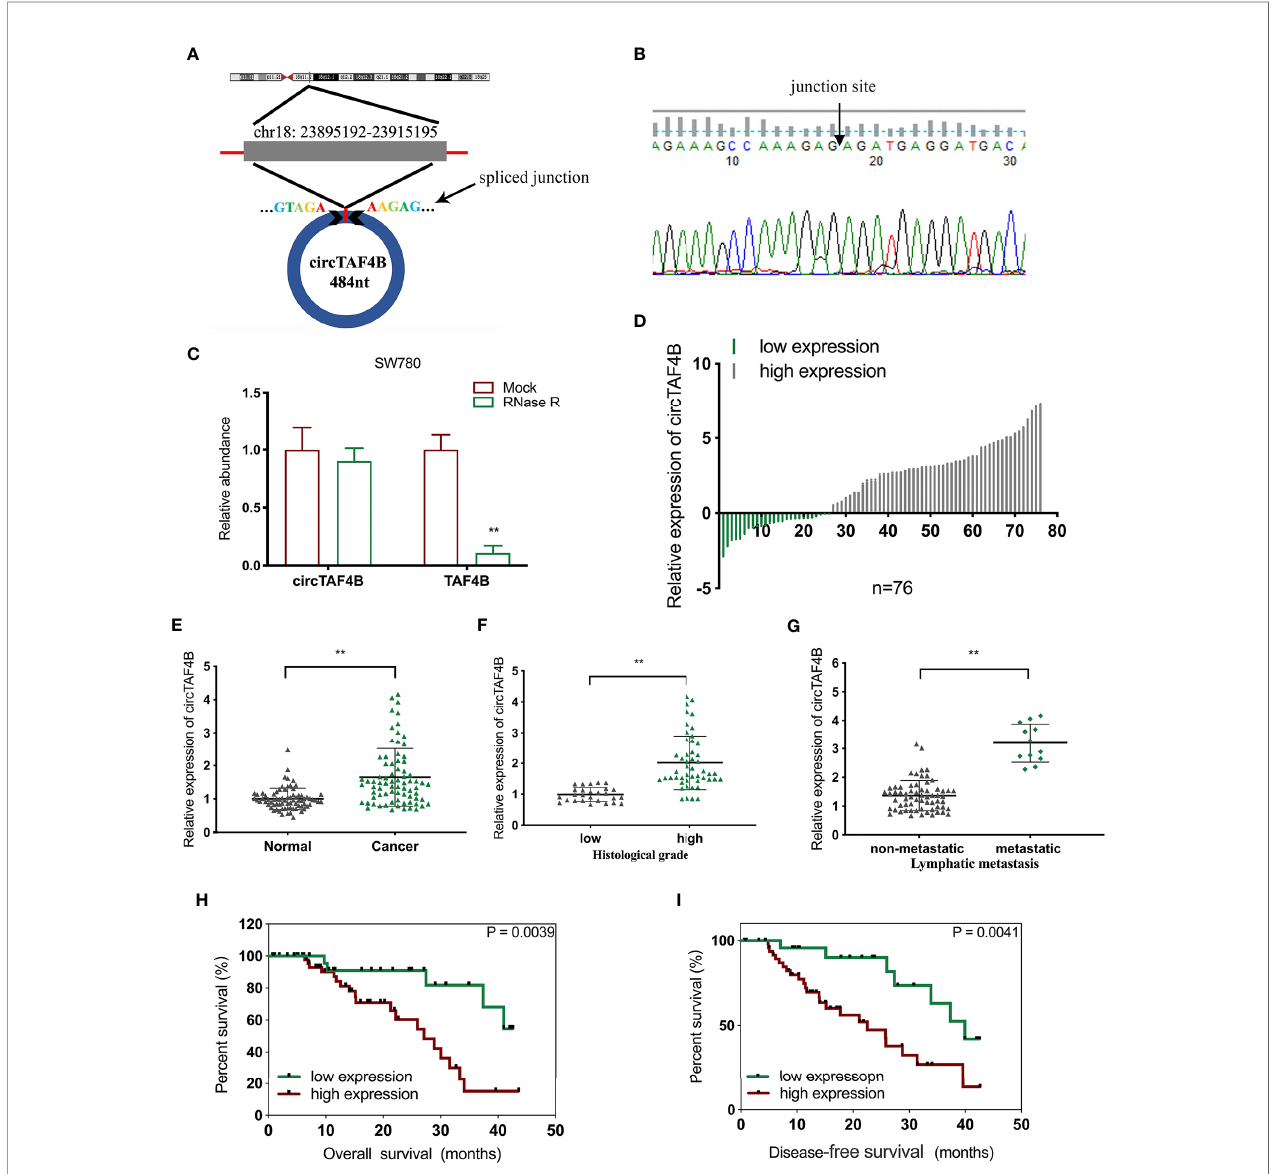
FIGURE 1 | circTAF4B was overexpressed in BCa tissues and associated with clinicopathological characteristics. (A) Schematic diagram of the circTAF4B structure and spliced junction. (B) The junction site of circTAF4B was con fi rmed by Sanger sequencing. (C) Compared with TAF4B mRNA, circTAF4B was not degraded by RNase R enzyme. (D, E) The expression levels of circTAF4B in tumor and adjacent normal tissues. (F) Differences in circTAF4B expression between tissues with high and low pathological grades of bladder cancer. (G) Differences in circTAF4B expression between patients with and without lymphatic metastasis. (H) Differences in overall survival time (OS time) between the circTAF4B high expression group and the circTAF4B low expression group. (I) Differences in disease-free survival (DFS) between the circTAF4B high expression group and the circTAF4B low expression group. Data represent the mean ± SD of more than three independent experiments. *p < 0.05; **p <